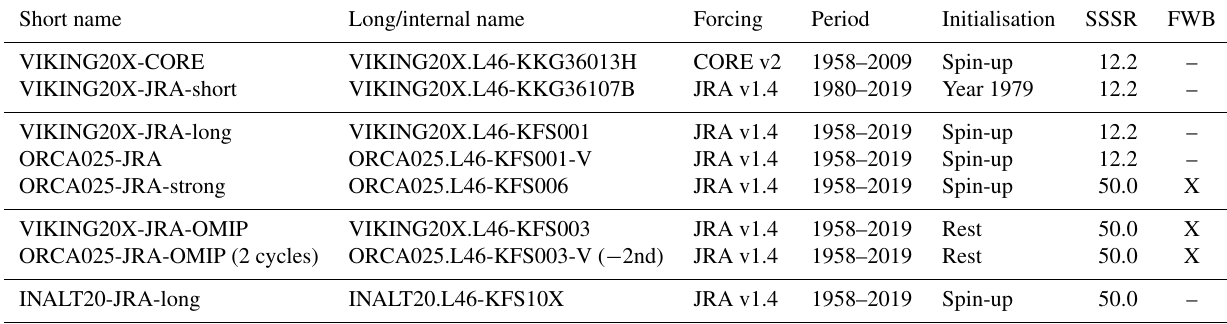
Table 1. Experiments with forcing and integration period. Also provided are internal names used to identify the specific experiments. For the initialisation, “Spin-up” refers to an experiment covering the period 1980 to 2009 under CORE forcing, “Rest” to an initialisation with temperatures and salinities of WOA13 and velocities at rest. VIKING20X-JRA-short was restarted from the end state of year 1979 of VIKING20X-CORE. SSSR is the sea surface salinity restoring timescale in myr − 1 ; FWB is a potentially used freshwater budget correction. Experiments are grouped according to their initialisation and application of freshwater